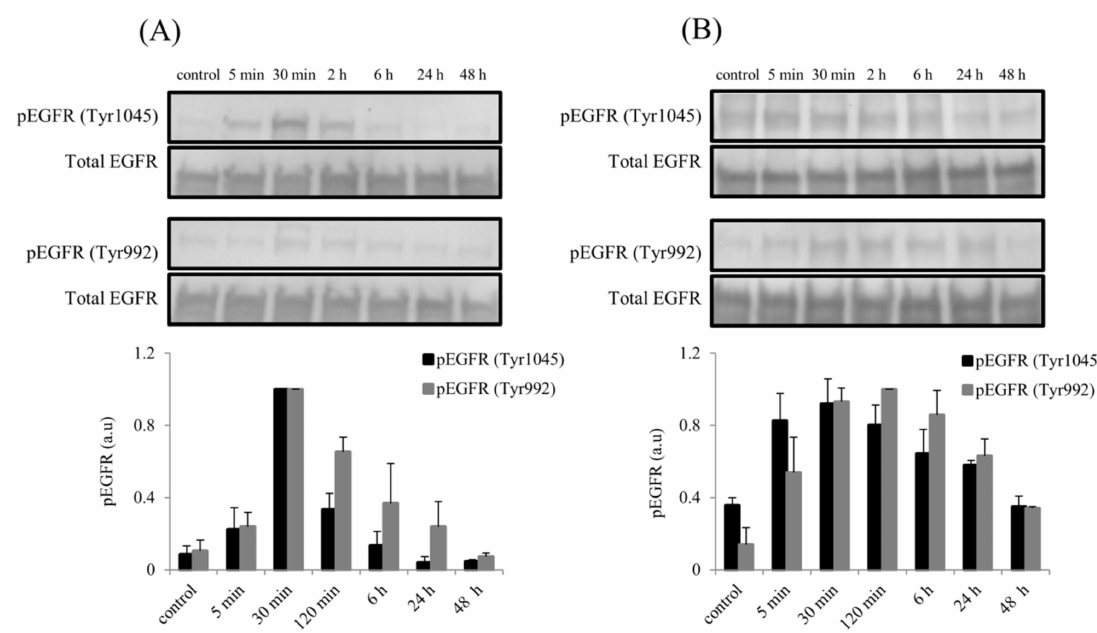
Figure 9. Activation of EGFR following BMP7 stimulation in ( A ) hTCEpi cells and ( B ) SFs. After BMP7 stimulation (100 ng/mL), total cell protein lysates were collected at time points 5 min, 30 min, 2, 6, 24, and 48 h and subjected to immunoblot analysis. Phosphorylation of EGFR at Tyr1045 and Tyr992 were analyzed using respective antibodies. Total EGFR protein levels were used to compare and calculate the differences in the phosphorylation levels. Differences in the phosphorylation levels (Tyr1045 and, Tyr992) were quantified using ImageJ software and the values were normalized to the corresponding total EGFR signal. Data represent mean ± standard deviation of the phosphorylation levels shown as arbitrary units from three independent experiments. One representative immunoblot of at least 3 independent experiments is